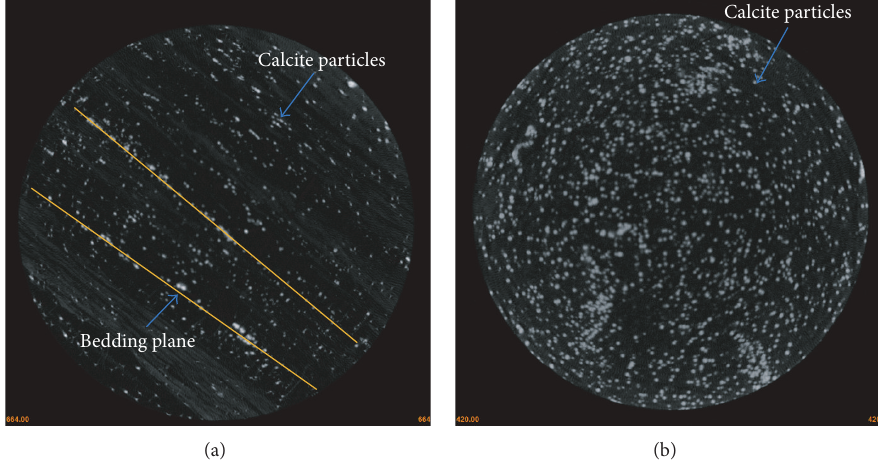
Figure 3: Typical cross-sectional ICT images of specimens: (a) scan of parallel specimen ( Φ 50 mm × H 100mm), (b) scan of perpendicular specimen ( Φ 50 mm × H